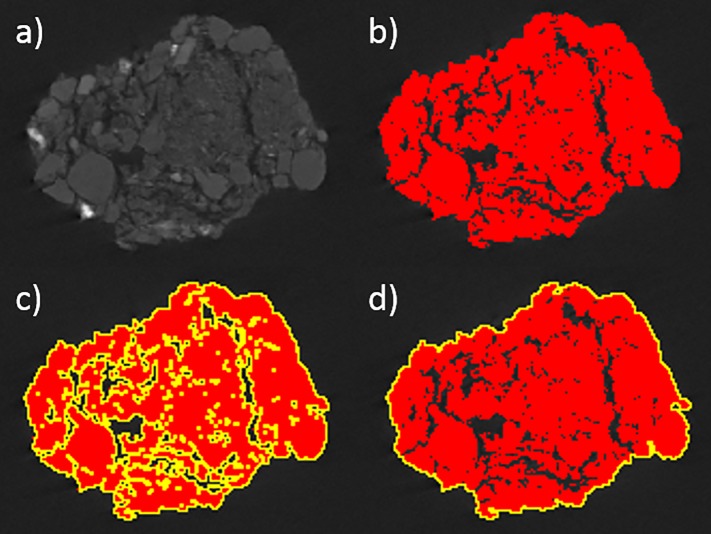
Images of a landscape aggregate slice, showing a) the original slice; b) the slice after thresholding; c) the thresholded slice following the 'Create Selection' command; and d) the thresholded aggregate slice with solely its external edge selected.